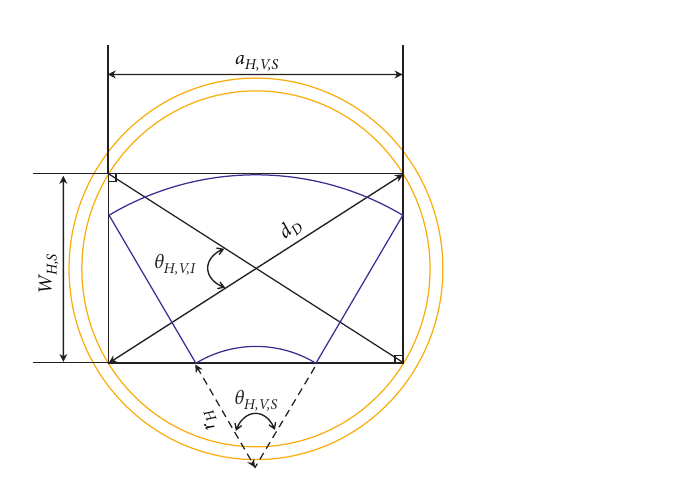
Figure 5: Side view of the piece resulting from horizontal and subsequent vertical segmentations of a hemispherical part of a spher- ocylinder-type object.